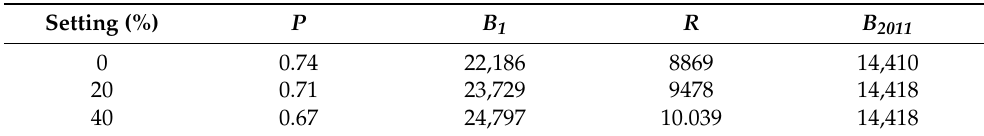
Table 3. SRA results under different unreported catch rate scenarios assuming M = 0.51 and B 2011 = 14,412 t.